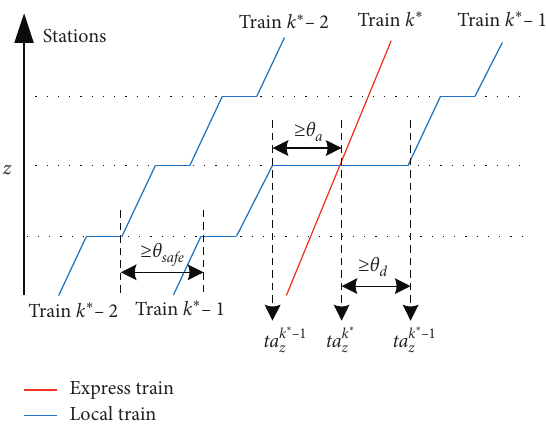
Figure 8: Illustration for time interval constraints at overtaking